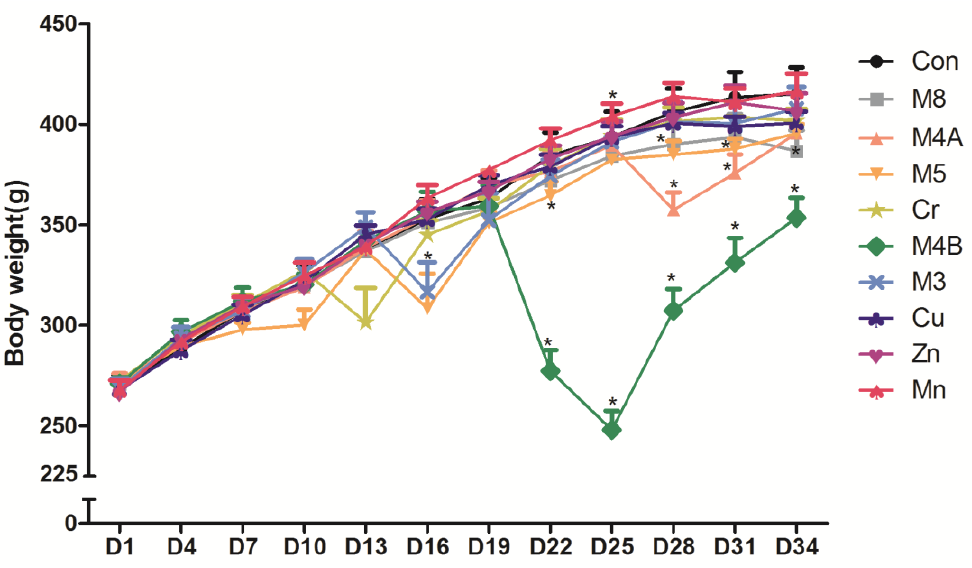
Figure 1. The body weight changes of rats during the experiment period. p < 0.05, vs . the control group, D1 represents the first day of the experiment, D34 represents the 34th day of the experiment, and so on. Abbreviations: Con, control group; M8: the mixture of eight common metals (Pb + Cd + Hg